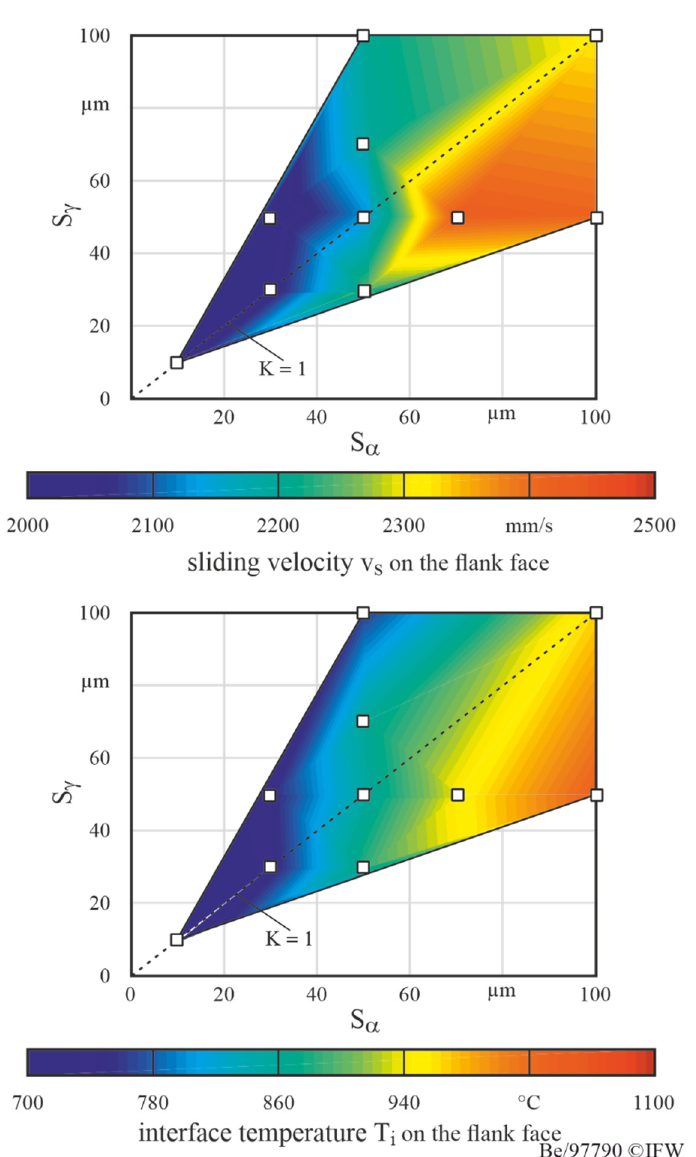
Figure 12. Thermal and kinematic load maps as a function of cutting edge segments S α and S γ during machining of